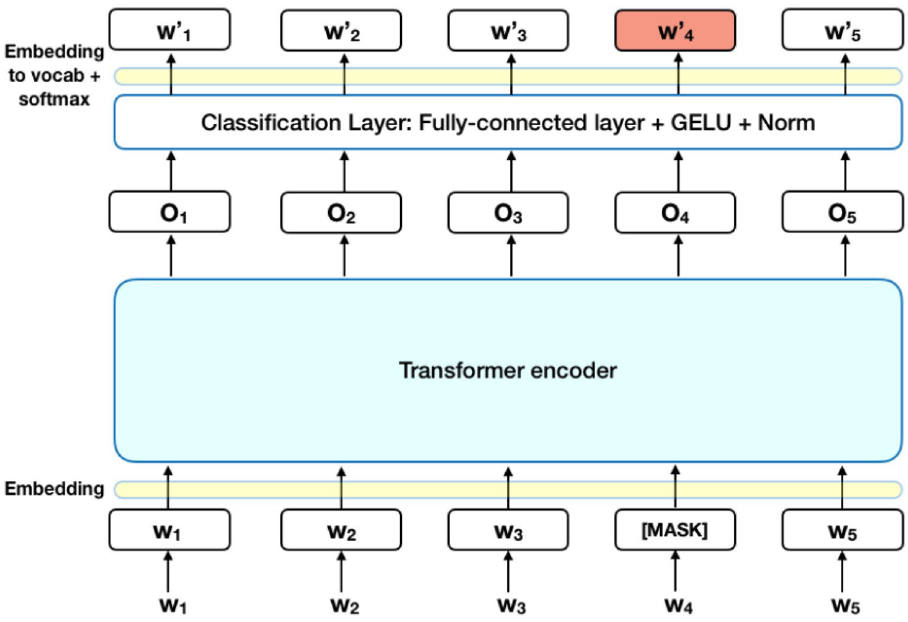
Figure 2. Bidirectional encoder representations from rransformers (BERT)